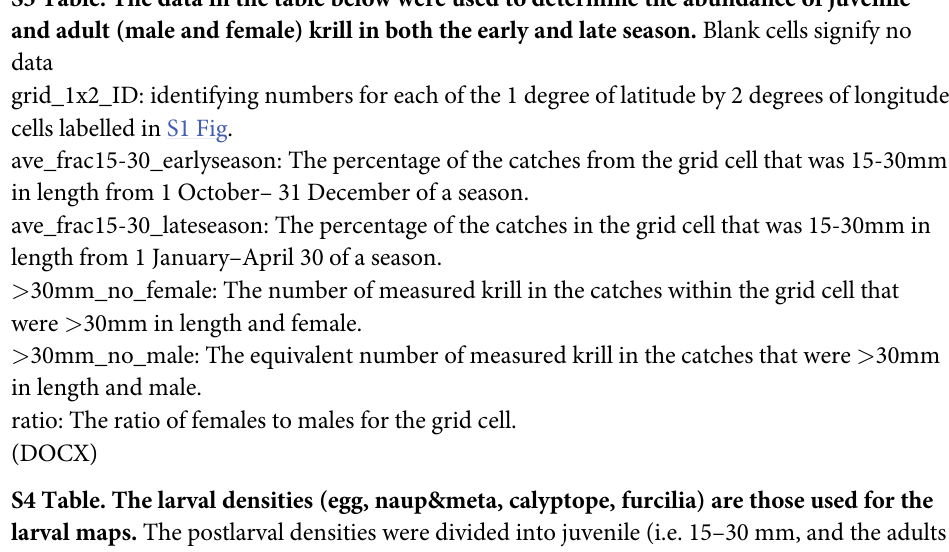
S3 Table. The data in the table below were used to determine the abundance of juvenile